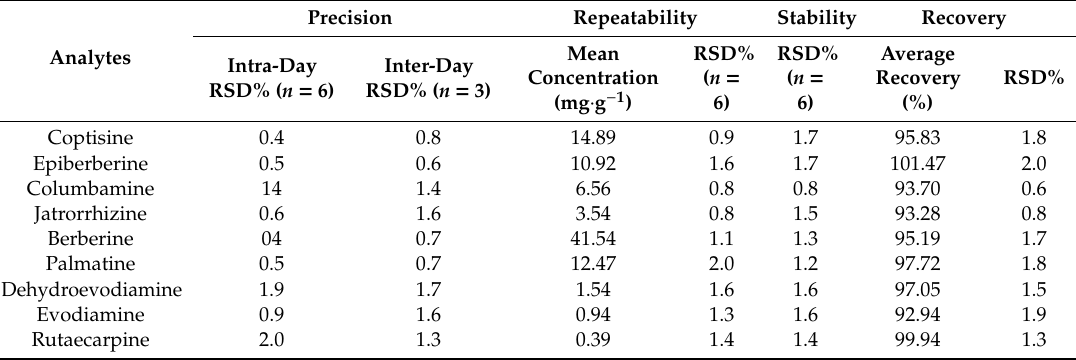
Table 3. Precision, stability, repeatability and accuracy of nine